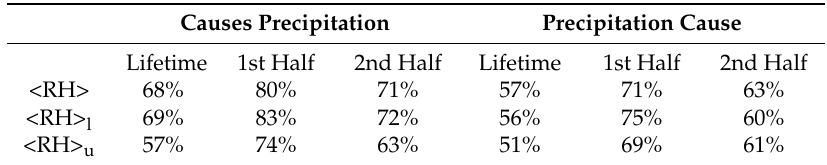
Table 2. The fraction of clouds for which one quantity granger causes the corresponding quantity. Causes Precipitation Precipitation Cause Lifetime 1st Half 2nd Half Lifetime 1st Half 2nd